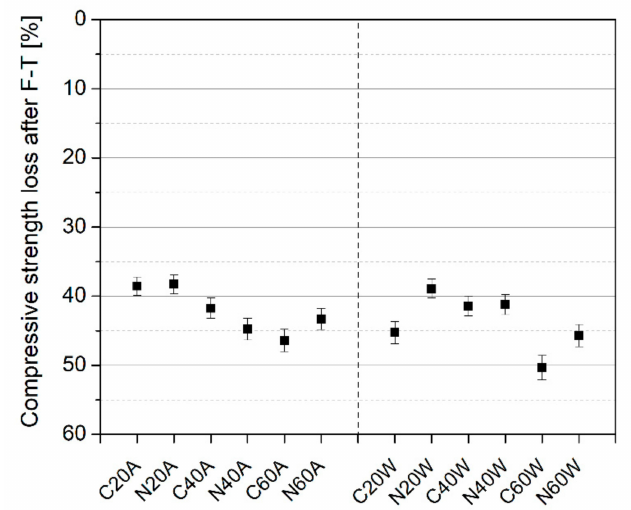
Figure 9. Compressive strength of mortar specimens, after exposure to freeze–thaw